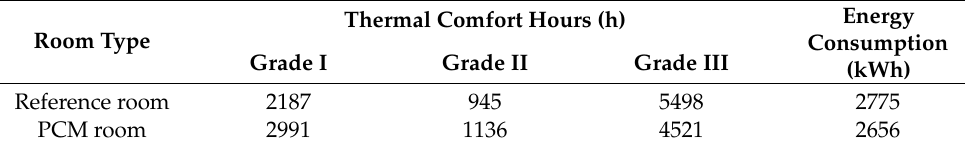
Table 8. Thermal performance of prefabricated temporary houses.